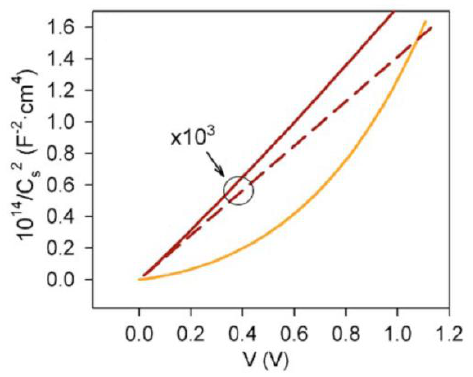
ND = 1,020 cm −3 (adopted from Ref. [49]).